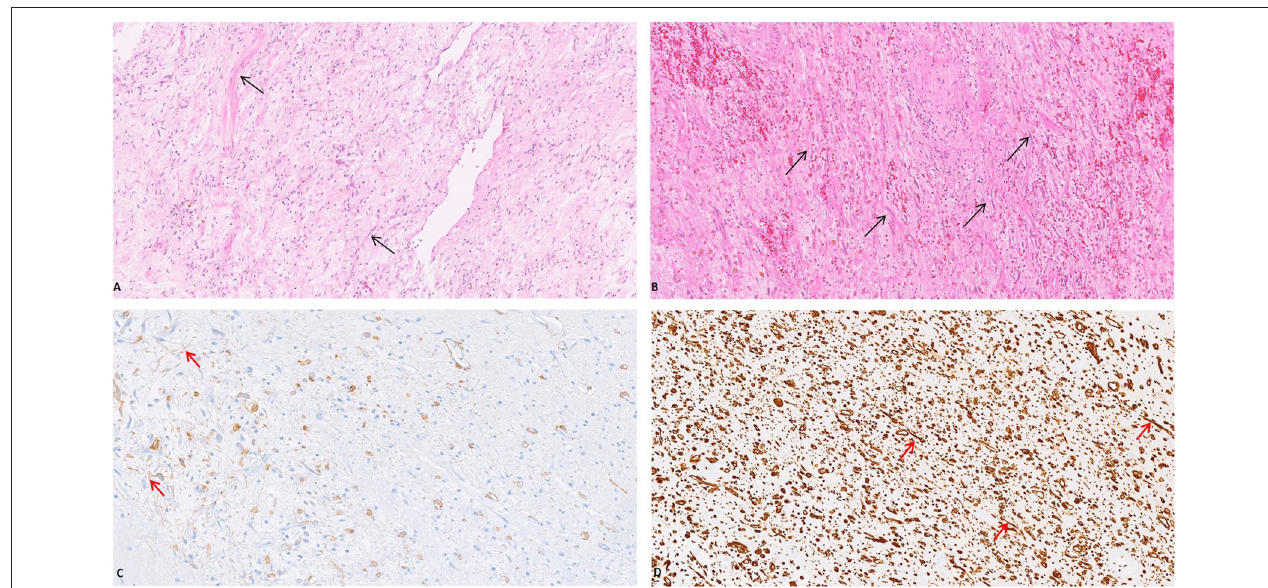
FIGURE 2 | The mesenteric mass was composed of a proliferation of bland-looking spindle cells with slightly eosinophilic cytoplasm and elongated normochromatic nuclei with mild nuclear atypia, haphazardly set in a collagenized stroma [ (A,B) (Arrow), H&E, 20x]. The myofibroblastic nature of the lesional spindle-shaped cells was confirmed by the expression of Smooth Muscle Actin [ (C) (Arrow), 20x] and Vimentin [ (D) (Arrow),